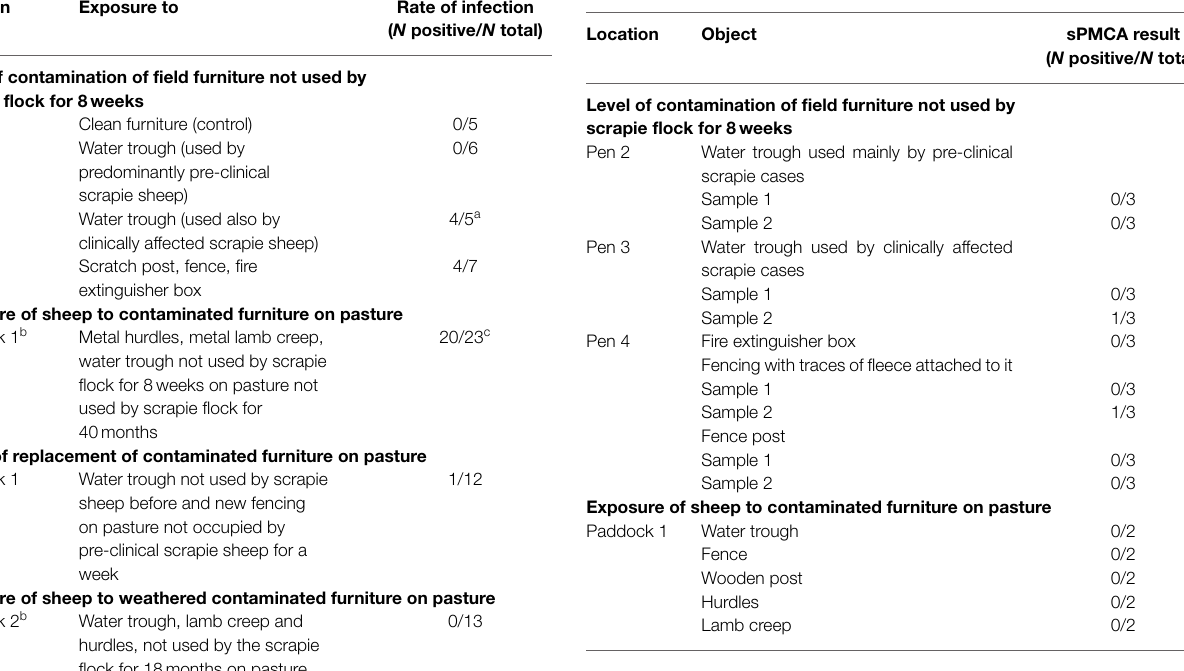
TABLE 1 | Summary of the results in each sheep study . TABLE 2 | Detection of PrP Sc by sPMCA in swabs from objects placed in clean housing and on pasture